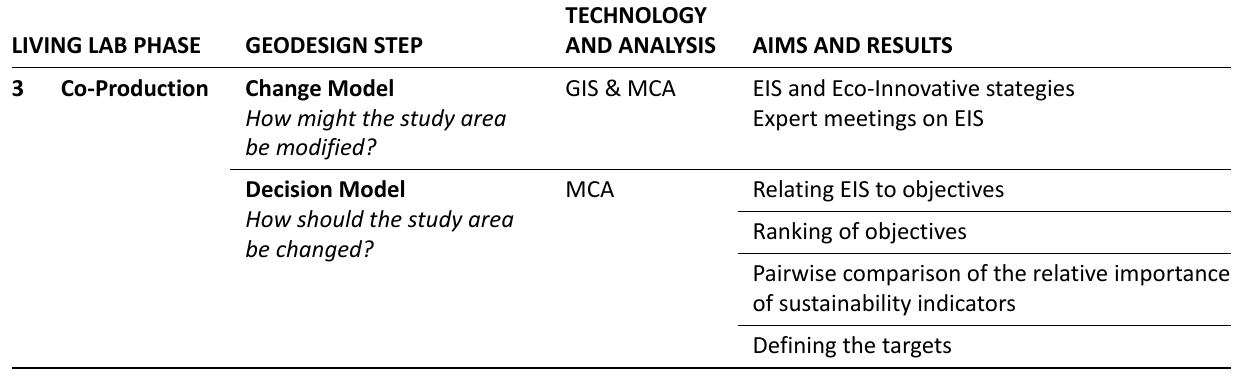
Table 4. Addressing geodesign questions at the PULL phase of